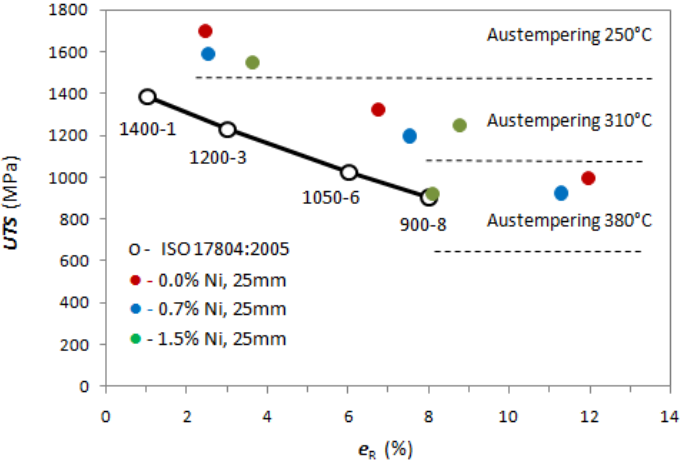
Figure 1. UTS (MPa) vs. e R (%) for the ADIs produced with different Ni contents and with three different austempering temperatures (austenitization similar for all compositions at 875 °C for 2 h) with round tensile specimens from 25 mm Y-blocks. Minimum tensile properties complying with ISO17804:2005 [48] are reported for comparison purposes. Indications of the austempering temperatures are reported on the plot for clarity’s sake.